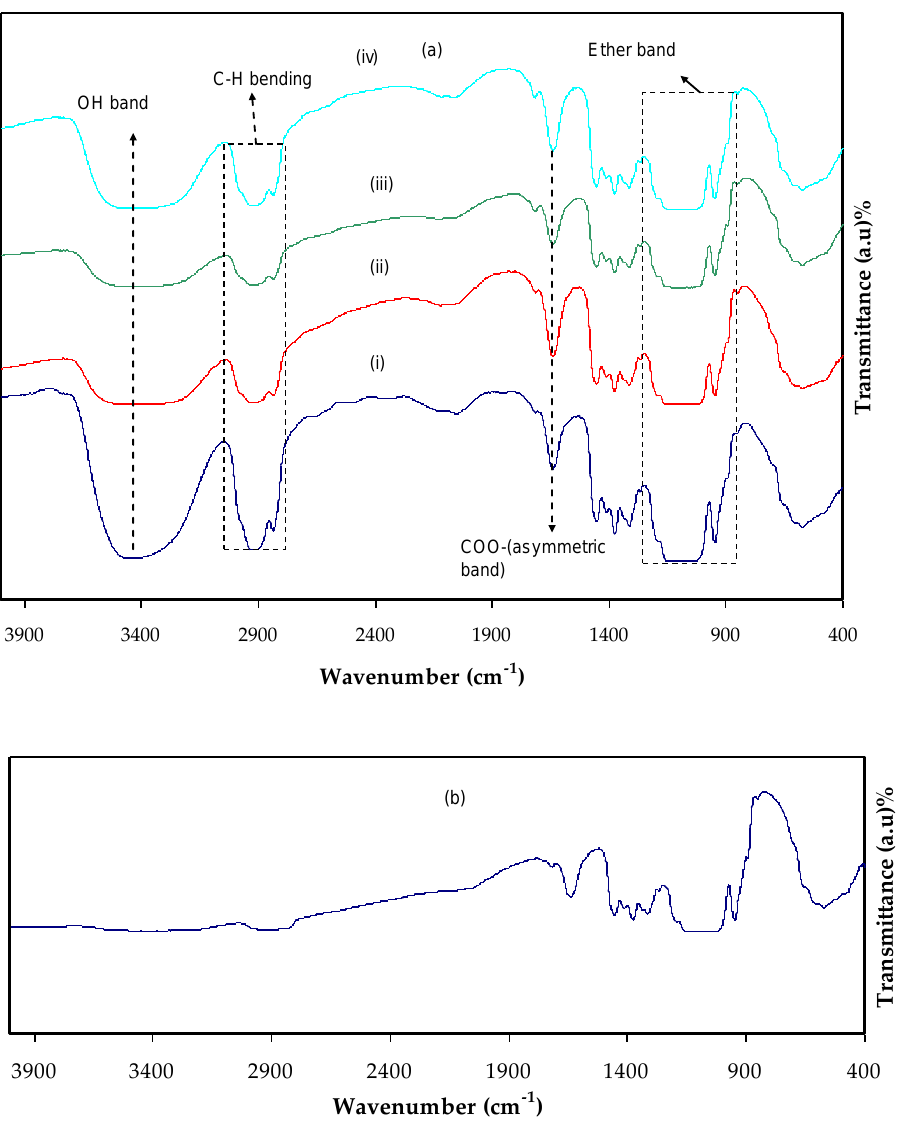
Figure 1. FTIR spectra at a wave number between 400 cm − 1 to 4000 cm − 1 ( a ) for (i) MCNAB1, (ii) MCNAB2, (iii) MCNAB3, and (iv) MCNAB4, and ( b ) for MCNAB5 electrolyte films.